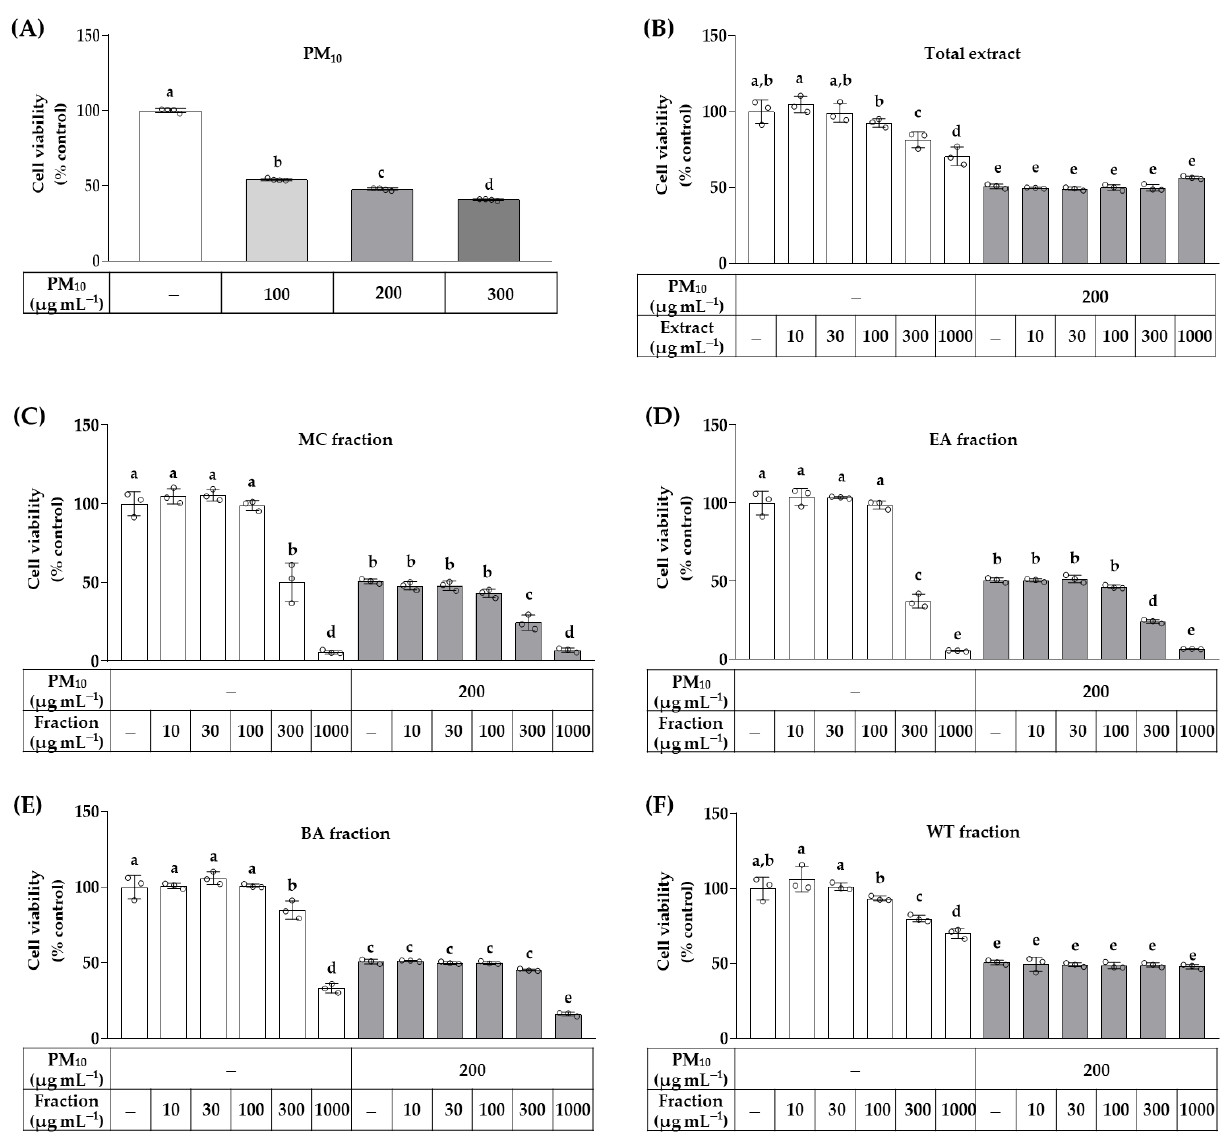
Figure 2. Effects of the total OJ extract and its solvent fractions on the viability of HaCaT keratinocytes exposed to particulate matter 10 (PM 10 ). In ( A ), cells were treated with PM 10 at different concentrations for 48 h. In ( B – F ), cells were treated with the total OJ extract ( B ), MC fraction ( C ), EA fraction ( D ), BA fraction € , or WT fraction ( F ) at the specified concentrations, alone or in combination with PM 10 (200 μg mL −1 ), for 48 h. Cell viability was determined using 3-(4,5-dimethylthiazol-2-yl)-2,5-diphenyl tetrazolium bromide (MTT). Data are presented as mean ± SD ( n = 4 for A, n = 3 for B–F). Duncan’s multiple range test was performed to compare all group means to each other. Groups that do not share the same lowercase alphabet letters (a–e) are considered to have significantly different means at the p < 0.05 level.